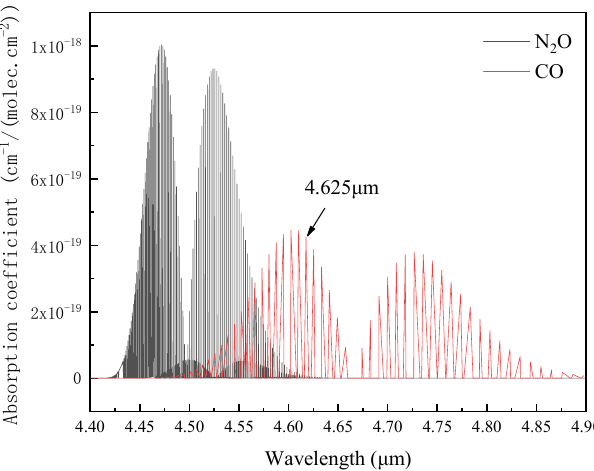
Figure 1. Absorption spectra of CO and N 2 O.